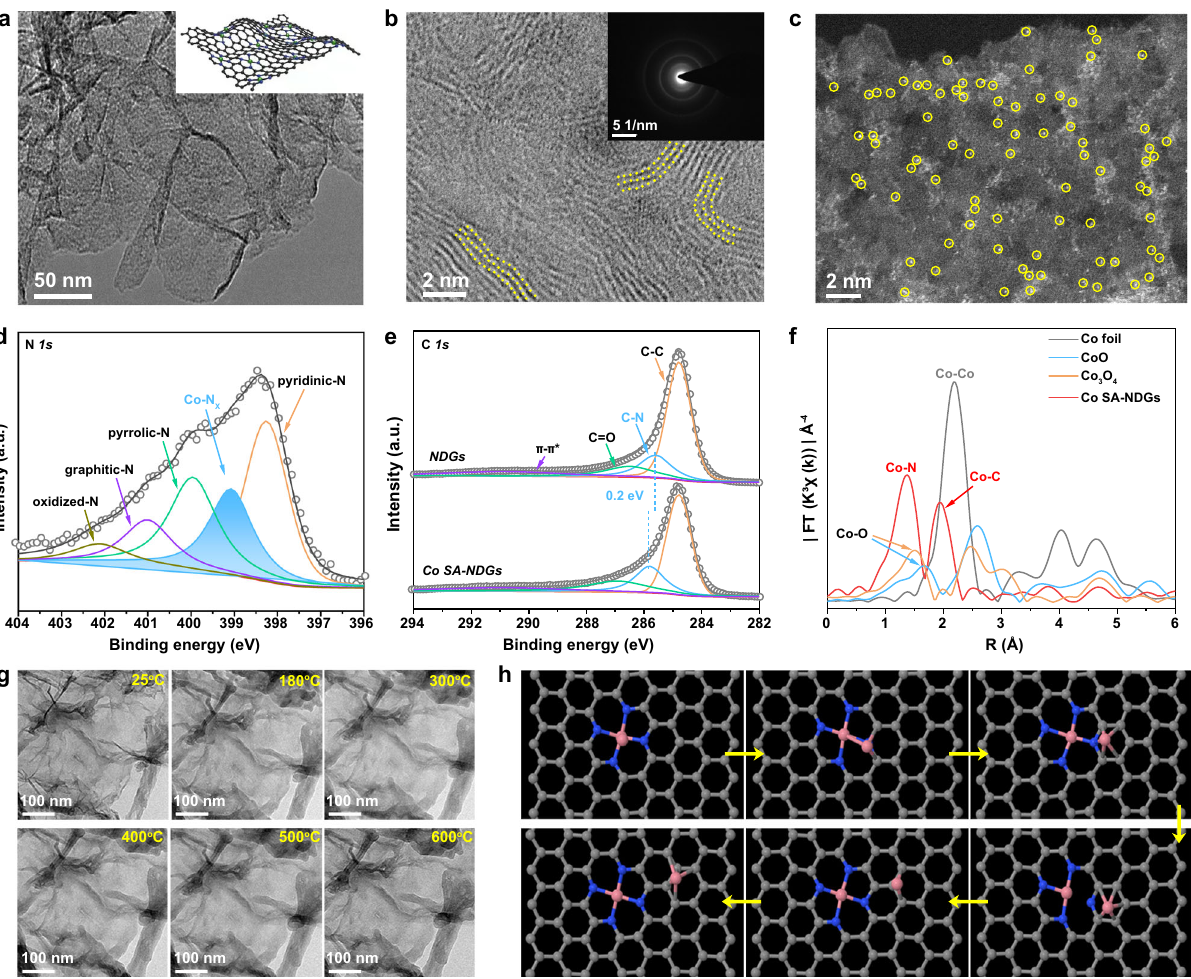
Fig. 1 Structural characterizations and theoretical simulations of Co SA-NDGs. a TEM image of Co SA-NDGs. Inset shows the corresponding curved model. b HRTEM image of Co SA-NDGs. Inset shows the corresponding SAED pattern. c AC HAADF-STEM image of Co SA-NDGs. d N 1 s spectrum of Co SA-NDGs. e C 1 s spectra of Co SA-NDGs and NDGs. f Fourier transform of EXAFS spectra of Co SA-NDGs, Co foil, CoO, and Co 3 O 4 at the Co K-edge. g In situ temperature-dependent TEM images recorded at varying temperature. h Molecular dynamic simulations to reveal the dynamic evolution of Co dimer. The pink, blue, and gray balls refer to Co, N, and C atoms,